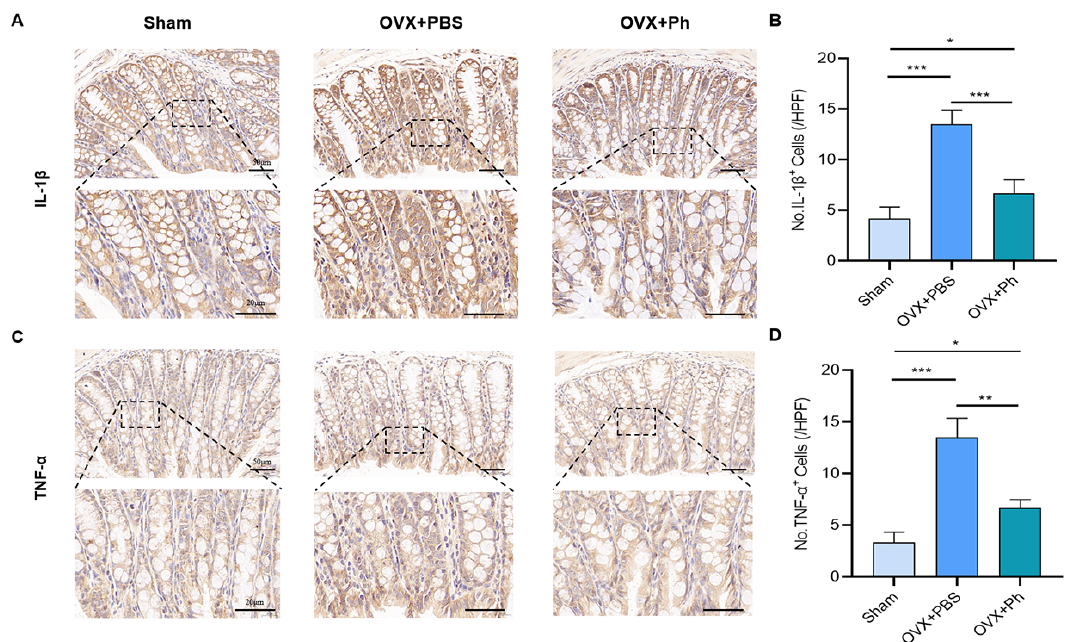
Figure 6. The perfusion of Ph decreased the intestinal inflammation mediated by OVX. ( A ) The IL-1β stained sections of colon tissues. The scale bars represented as 50 μm and 20 μm; ( B ) No. IL- 1β + cells; ( C ) TNF- α stained sections of colon tissues. The scale bars represented as 50 μm and 20 μm; ( D ) No. TNF- α + cells. * p < 0.05, ** p < 0.01, and *** p < 0.001 compared with comparable group.